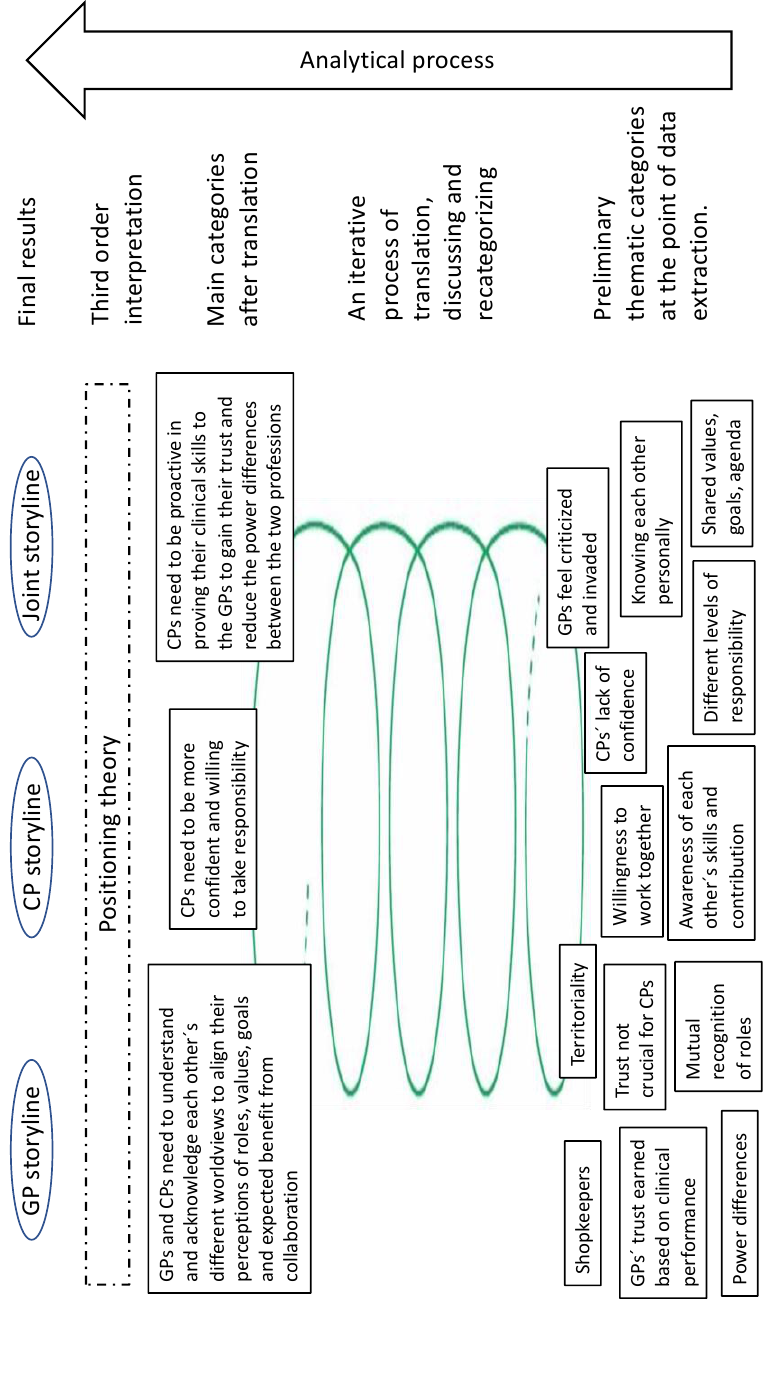
Figure describing the analysis process from preliminary thematic categories to final